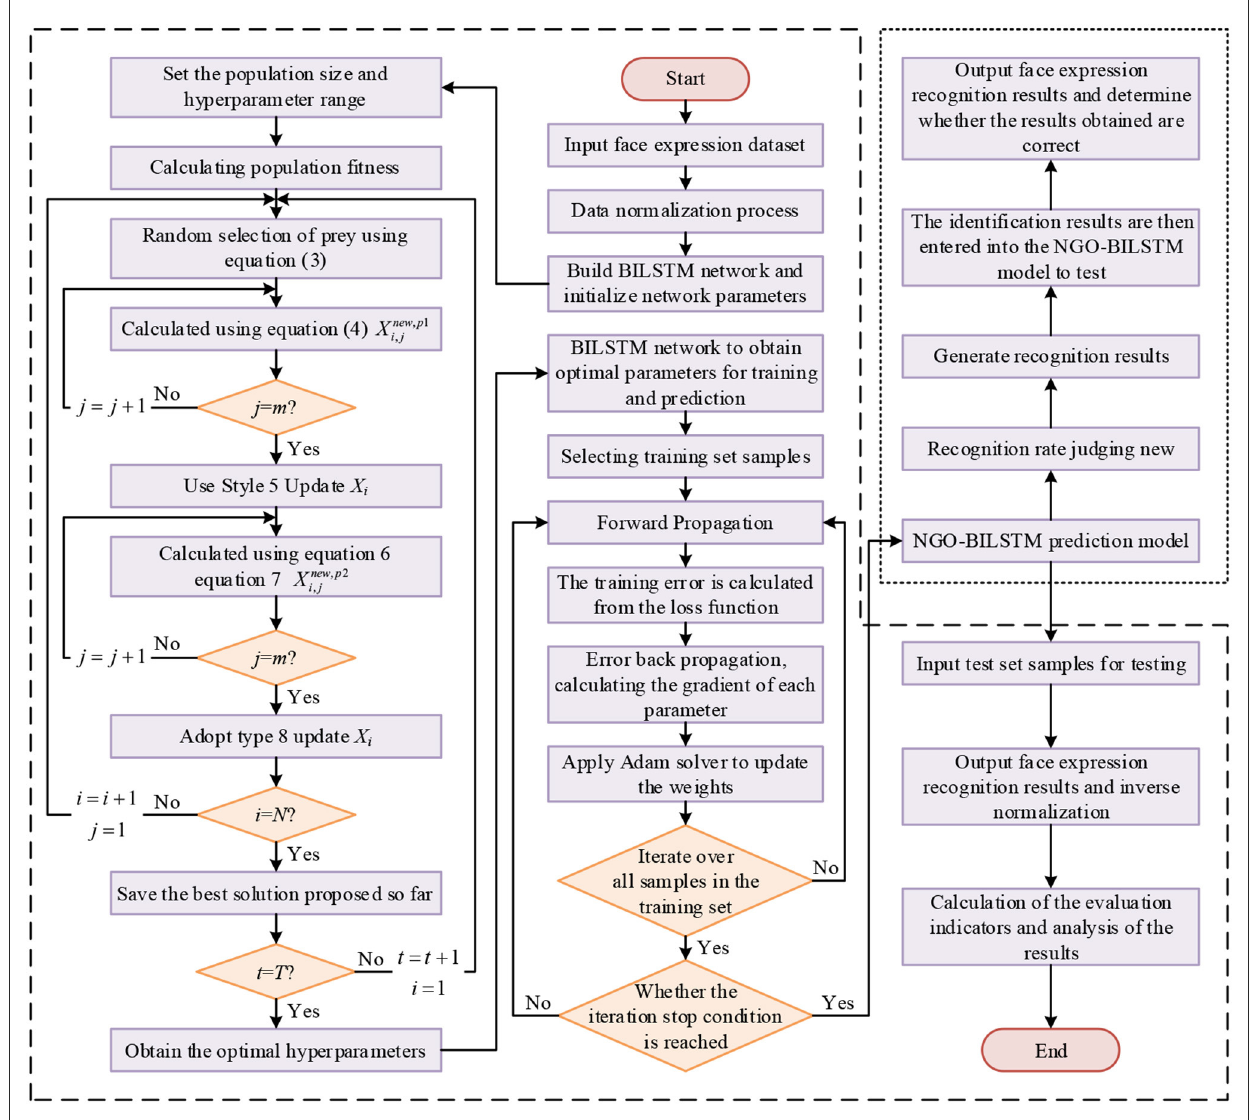
FIGURE3 Flowchart of facial expression recognition based on NGO-BILSTM.